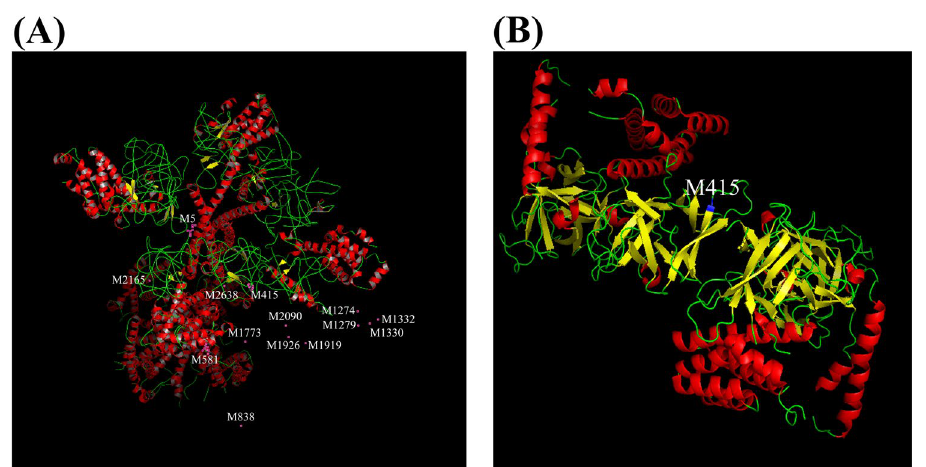
Figure 6. The location of each MBP-modified methionine in IP3R1 structure. ( A ) Cryo-EM imaging of IP3R1 displays the sheets (yellow), helixes (red) and loops (green); each MBP-modified methionine listed Table 1 is labeled with pink spot in IP3R1. However, majority of MBP-modified Mets are constructed by hydrogen linkages (pink spots in dark empty spaces). Met-5, Met-415 and Met-581 are located in loop and sheet respectively. ( B ) Crystal structure of IP3 binding domain from IP3R1 shown in Met-415 (blue) is in the boundary between sheet and loop. Both Cryo-EM imaging and crystal imaging have been used to represent the information from Protein Data Bank (PDB) and the 3D structure built using PyMOL